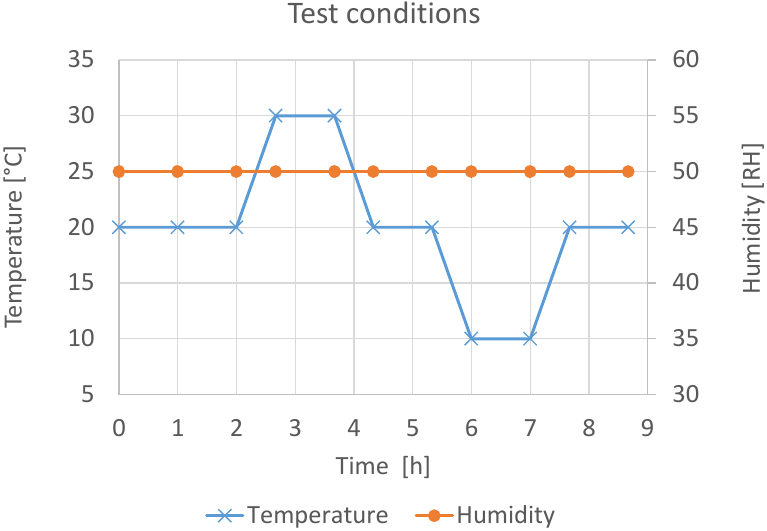
Figure 9. Test conditions for the measurement of temperature stability. During the test, the measured values of the sensors were recorded and afterwards plotted in an angle over temperature diagram, as shown in Figure 10. The slope of the linear fit with the method of least squares was used to obtain the temperature stability.